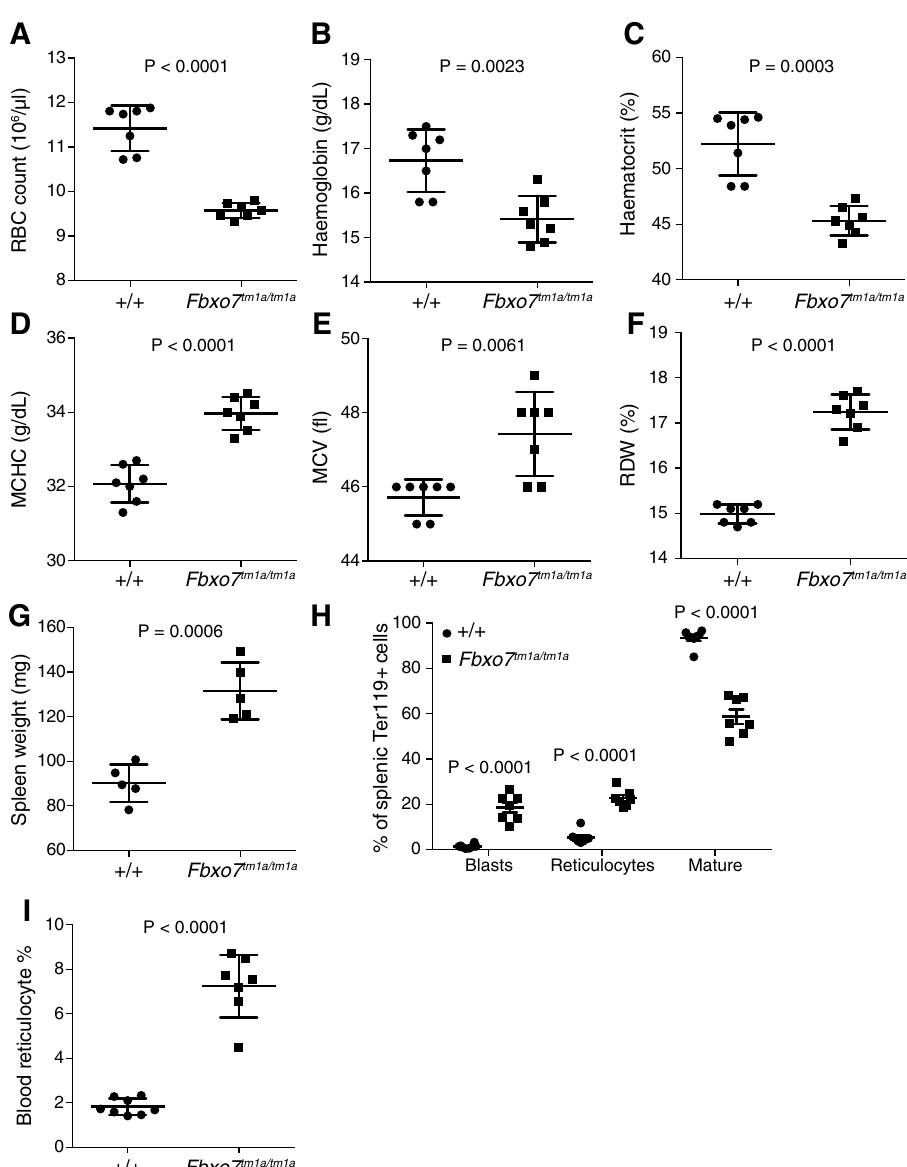
Fig 1. Fbxo7 targeted mice present with anaemia and extramedullary haematopoiesis. (A) Red blood cell count (RBC); (B) haemoglobin; (C) haematocrit; (D) mean corpuscular haemoglobin concentration (MCHC); (E) mean corpuscular volume (MCV); (F) red blood cell distribution width (RDW); (G) spleen weight; (H) characterisation of splenic erythrocyte development; and (I) circulating reticulocyte; from 15–17 week old Fbxo7 +/+ and Fbxo7 tm1a/tm1a female mice. P values calculated from unpaired two-tailed students t tests with Welch’s correction (A-G, I), or unpaired two-tailed students t tests with Holm-Sidak multiple testing correction (H). The data are representative of at least 3 independent experiments and each symbol represents an individual mouse with the line at the mean and error bars represent standard deviation or standard error of the mean for panel H.